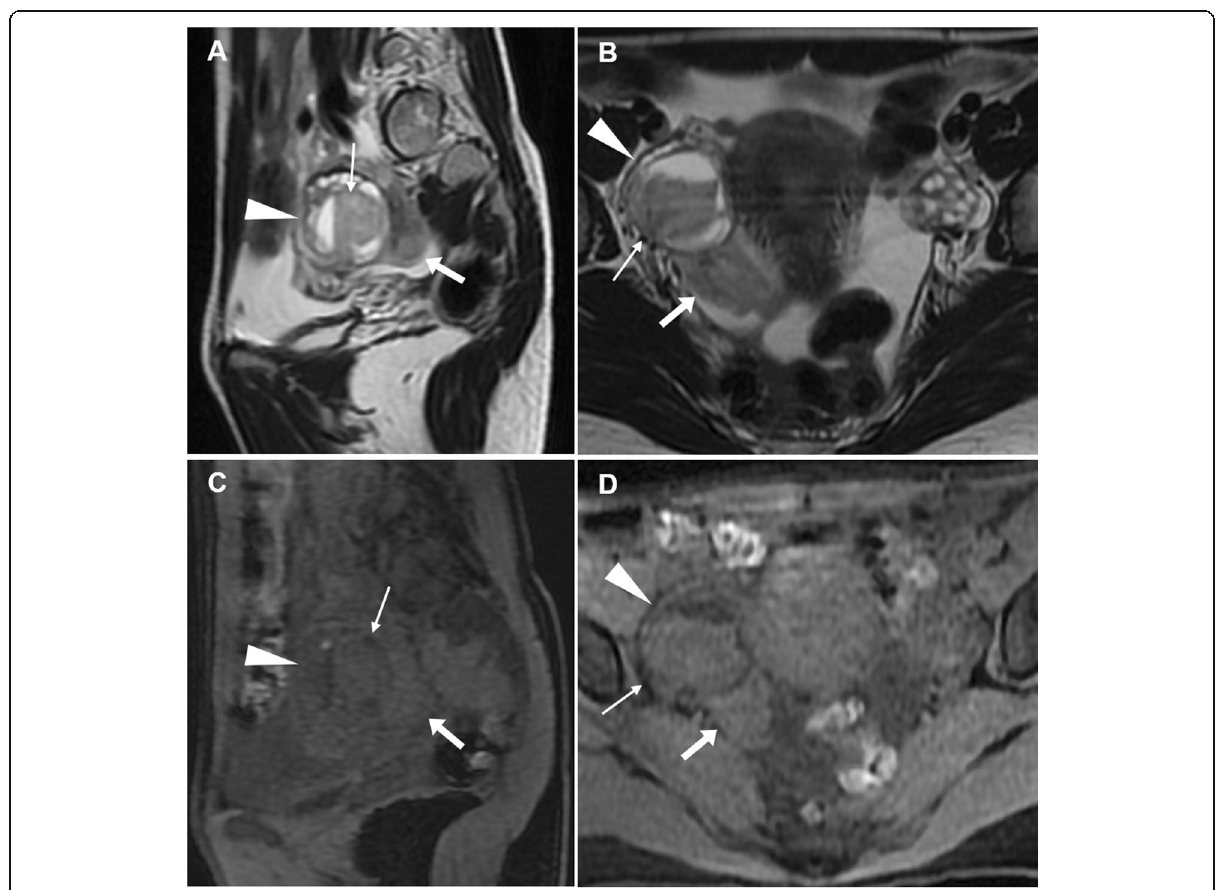
Fig. 14 Ruptured haemorrhagic corpus luteum with haemoperitoneum in an 18-year-old woman with pelvic pain for 24 h. Sagittal ( a ) and oblique-coronal ( b ) T2-weighted, sagittal ( c ) and oblique-coronal ( d ) precontrast fat-suppressed T1-weighted images show right-sided ovarian cyst (arrowheads) with internal fluid-fluid level and a dependent component with intermediate signal intensity on T1- and T2-weighted images (thin arrows), corresponding to recent haemorrhage (< 48 h). Note the haemorrhagic peritoneal effusion with intermediate signal intensity on both T1 and T2-weighted images adjacent to the posterior aspect of the cyst